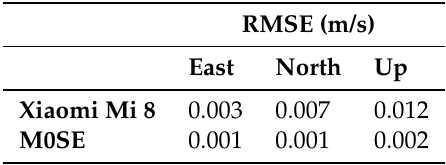
Table 1. Root mean square errors (RMSEs) for VADASE solutions with the two different GNSS receivers.